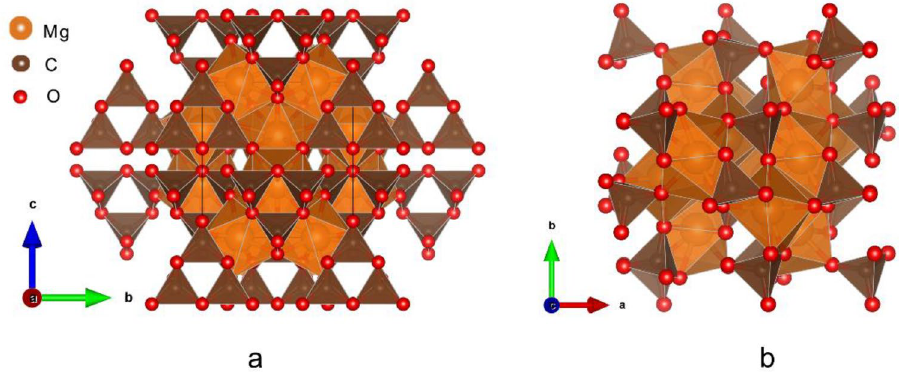
Figure 1. Crystal structures of MgCO 3 - C 2/ m ( a ) and Mg 2 CO 4 - P 2 1 / c ( b ) in unit cell. The crystal structures are drawn by VESTA 32 .